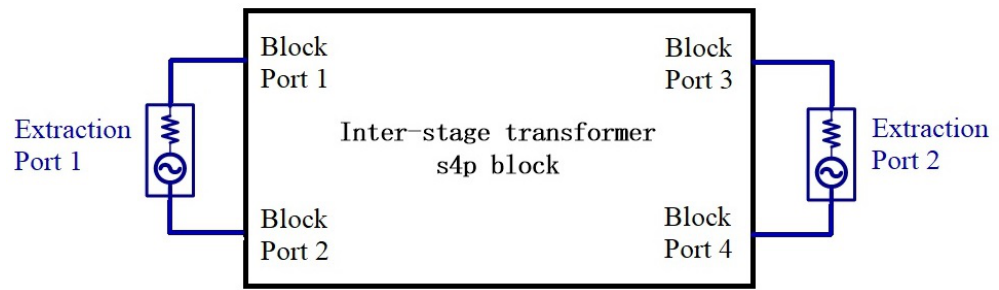
Figure 7. EM setup with layout of the inter-stage transformer.